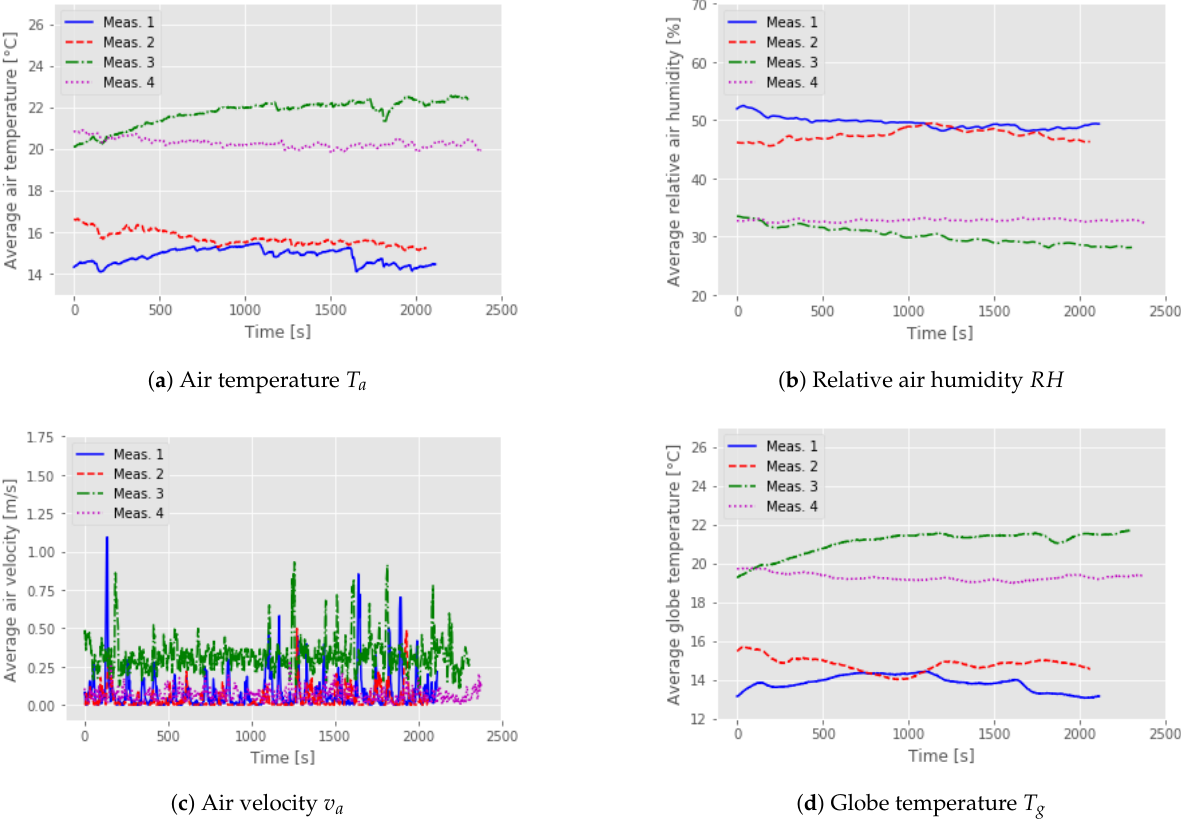
Figure 8. Average measured climatic parameters for Meas. 1 (blue, solid line), Meas. 2 (red, dashed line), Meas. 3 (green, dash-dotted line) and Meas. 4 (purple, dotted line). ( a ) shows the air temperature, ( b ) the air humidity, ( c ) the air velocity, and ( d ) the globe temperature.